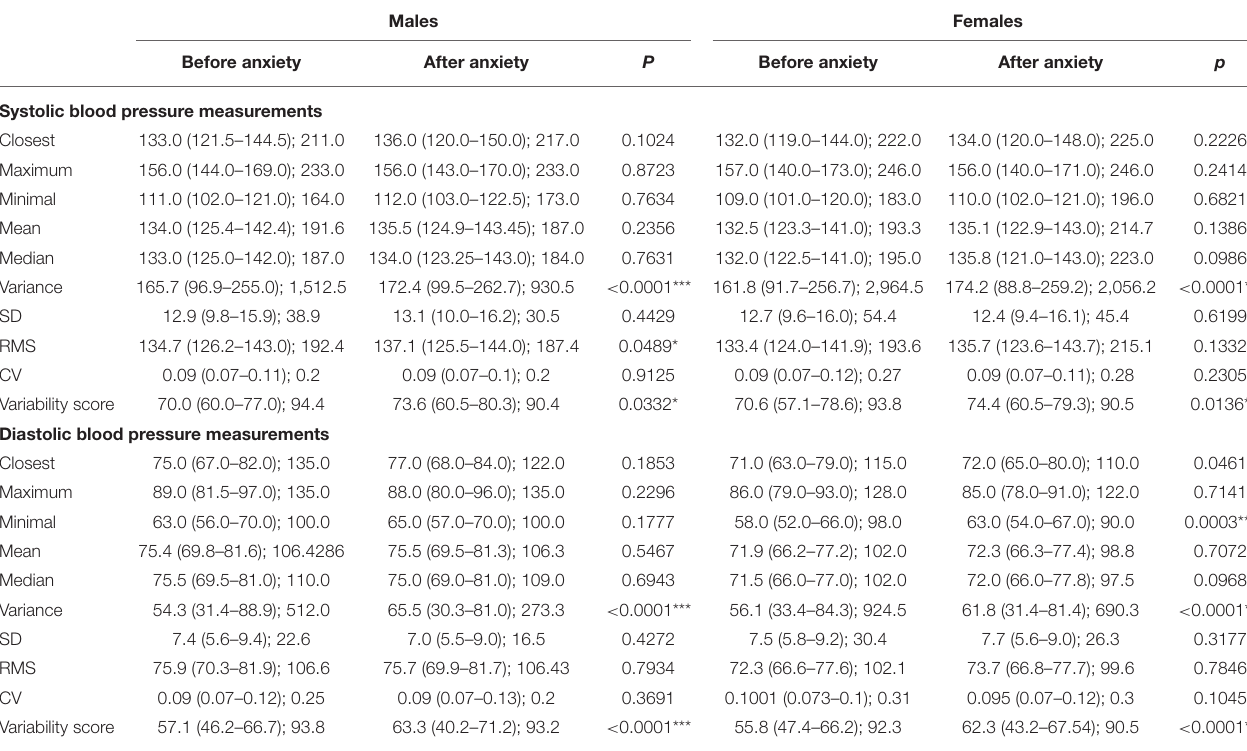
TABLE 4 | Gender-specific blood pressure measurement changes before and after anxiety development. Males Females Before anxiety After anxiety P Before